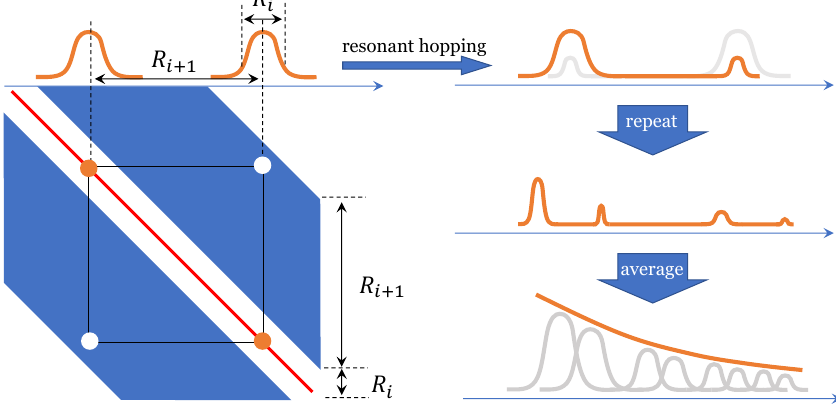
Figure 3: Formation of the wavefunction tails by RG. At i th step of RG bare eigen- states localized at distance R (shown by orange curves in the top left and as orange i circles on the diagonal of the matrix in the bottom left) are affected by hybridization via resonant hopping (white circles within blue non-resonant ones in the matrix) with (cid:29) R eigenstates located at distance R . At later RG steps, R , the wavefunction i + 1 i 0 hybridization is dominated by small angles θ , Eq. (7c), determining the amplitude of the hybridized eigenstate at the distance R with respect to the one localized i + 1 at R via the effective hopping, Eq. (8) (top right). Further steps of RG (middle i right) and the disorder averaging (bottom right) form the typical wavefunction